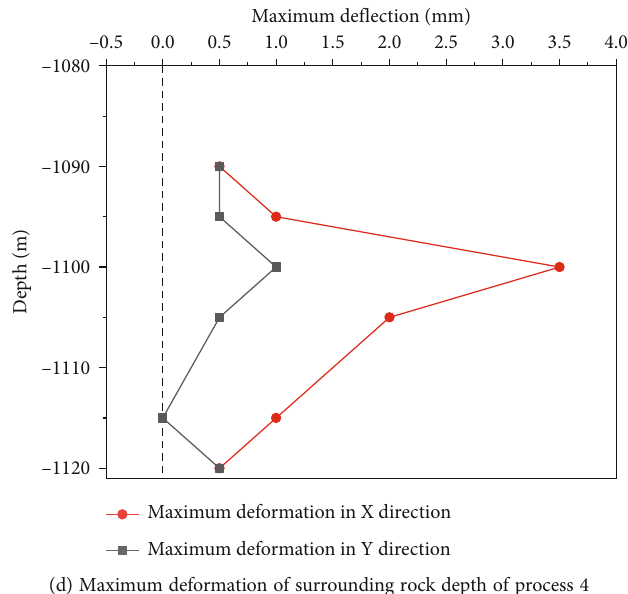
Figure 6: Maximum deformation of surrounding rock process.